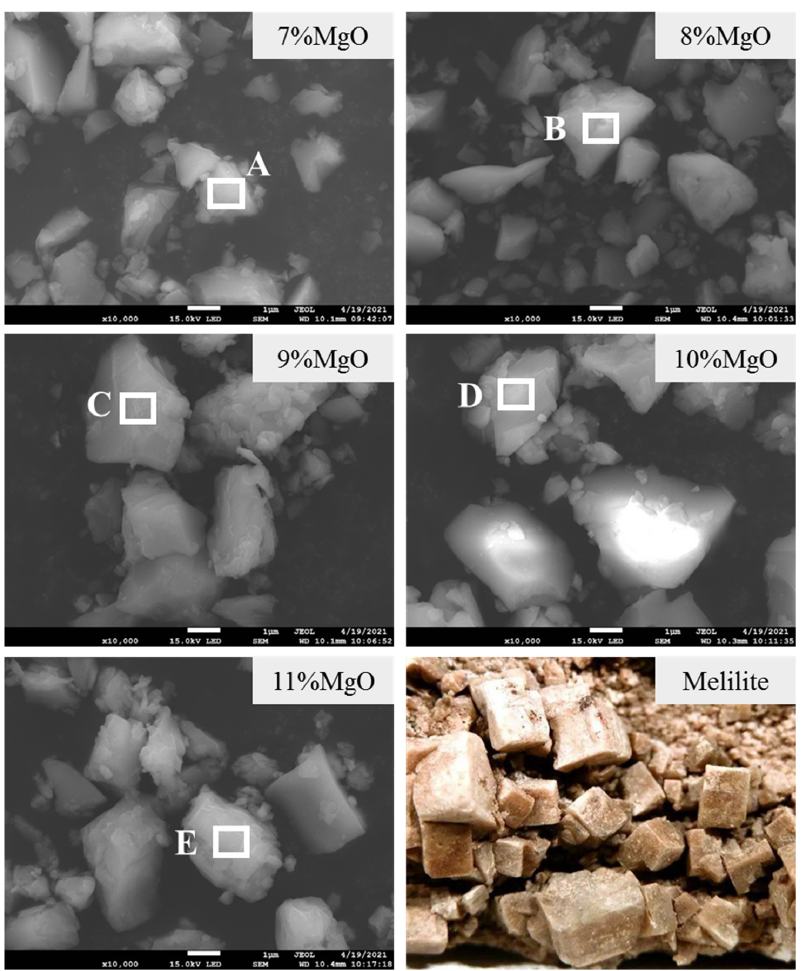
Figure 9. SEM photos of the microstructure of BF slag with different contents of MgO ( A -7% MgO,